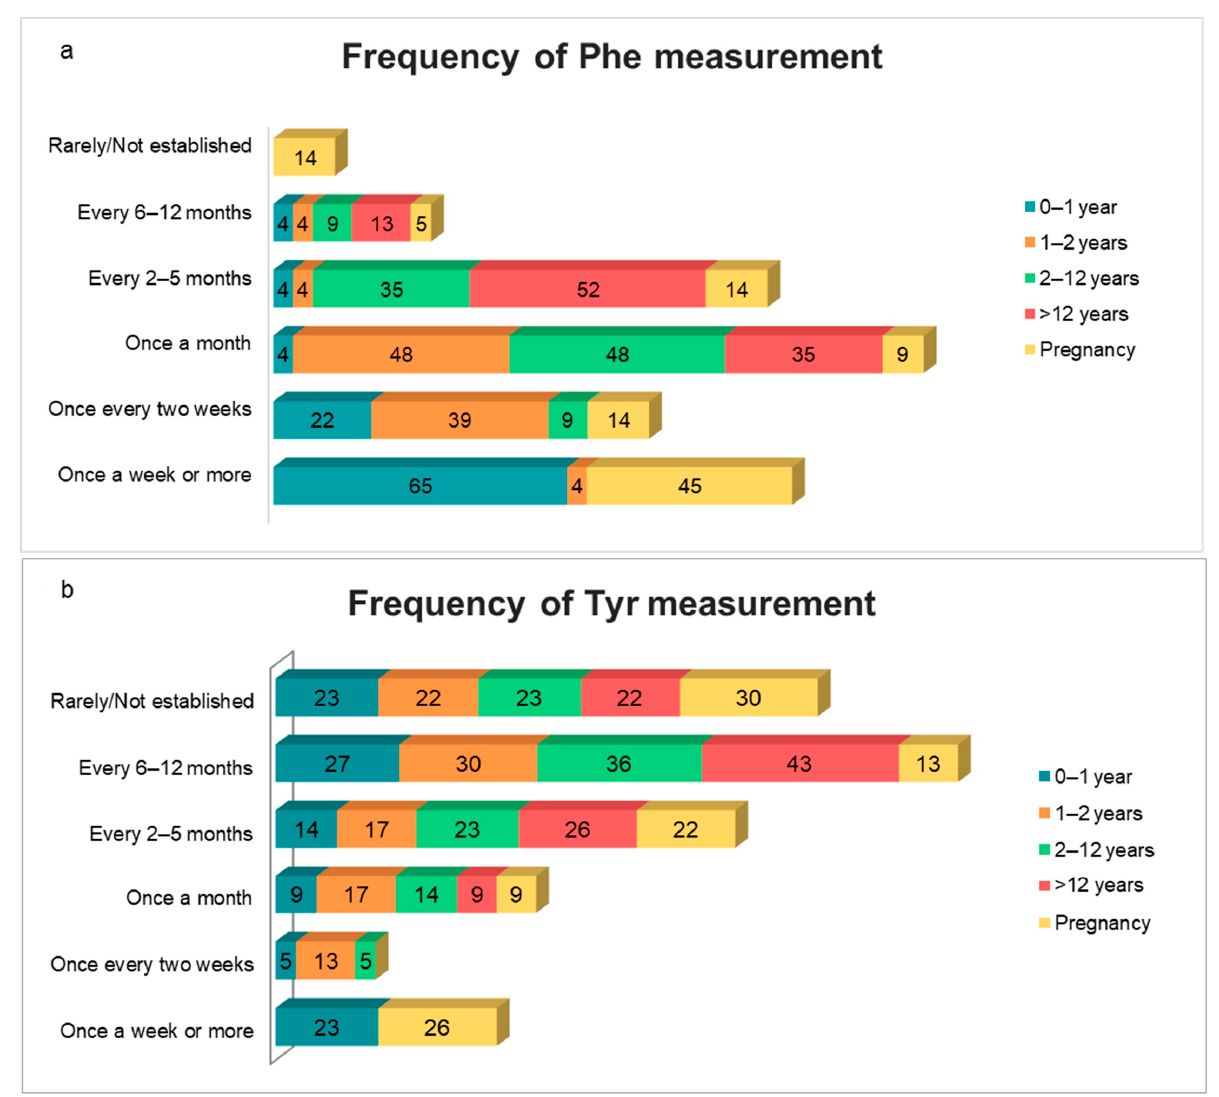
Figure 1. Frequencies of blood phenylalanine (Phe, 1a ) and tyrosine (Tyr, 1b ) monitoring for each age group as adopted by the Latin American centers included in the study ( n = 22). Numbers within columns represent relative percentages.